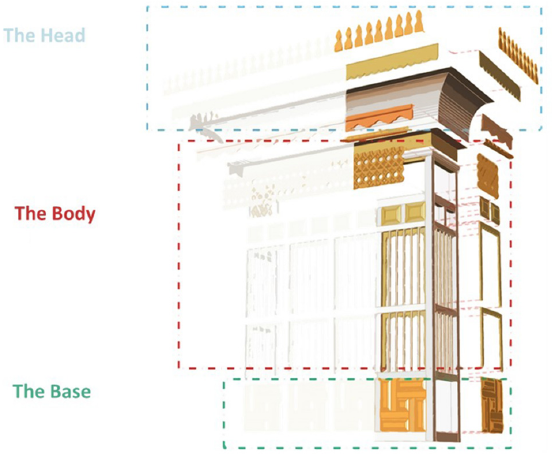
Figure 4. Roshan frame structure.